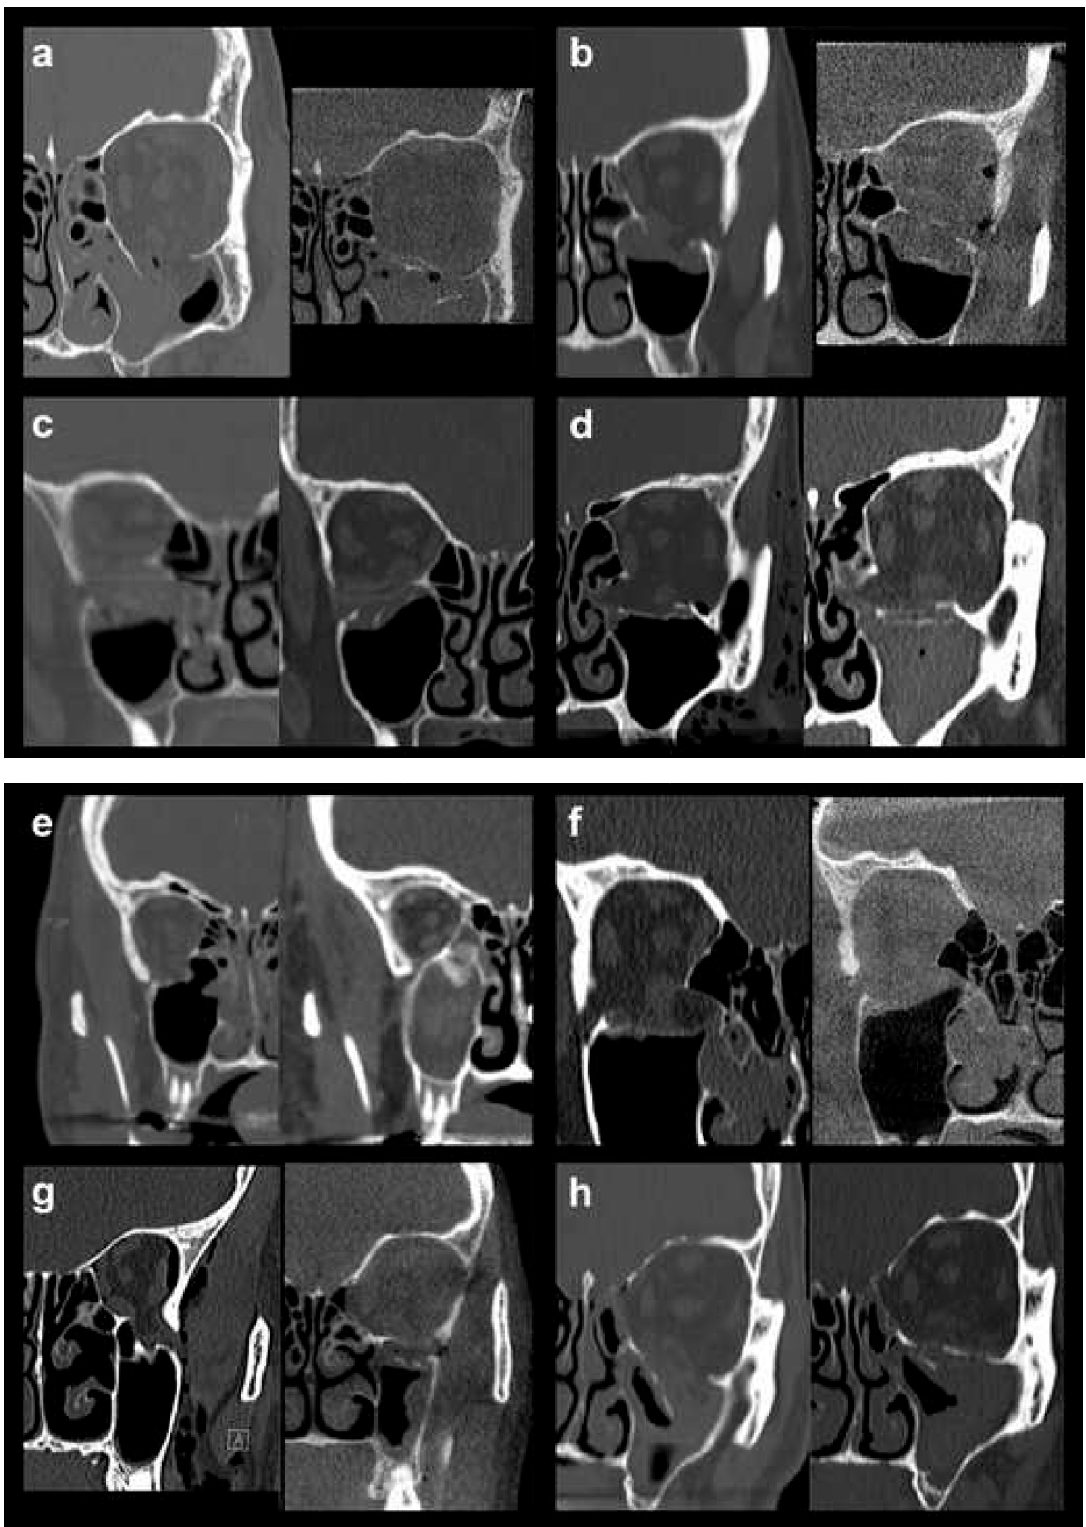
Figure 1. Pre- and postoperative conventional or cone-beam CT scans (coronal views) of all 7 class III fractures ( a – g ) and 1 class IV fracture ( h